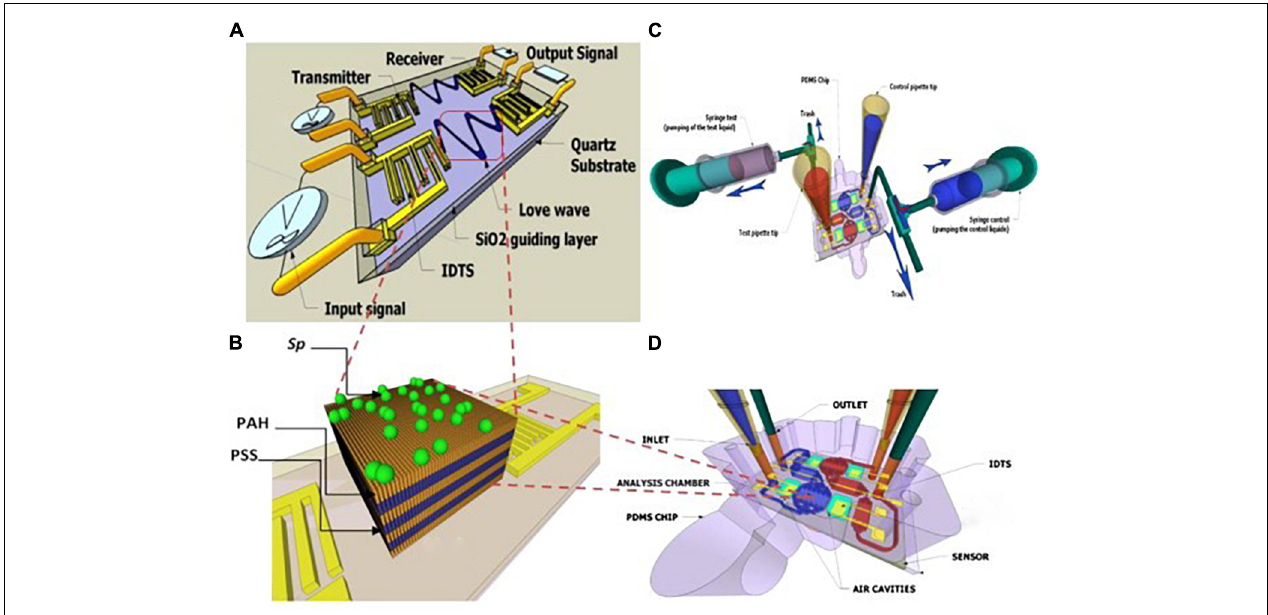
FIGURE 11 | Schematic of a SAW sensor with a hybrid biofilm of polyelectrolyte microalgae. (A) Scheme of SAW. (B) Spirulina immobilization on a polyelectrolyte multilayer (PEM) coated with a layer by layer (LBL) method. (C,D) hydrodynamic chip with microfluidic network, aligned on SAW (104) (Copyright permission: 5179190742544).